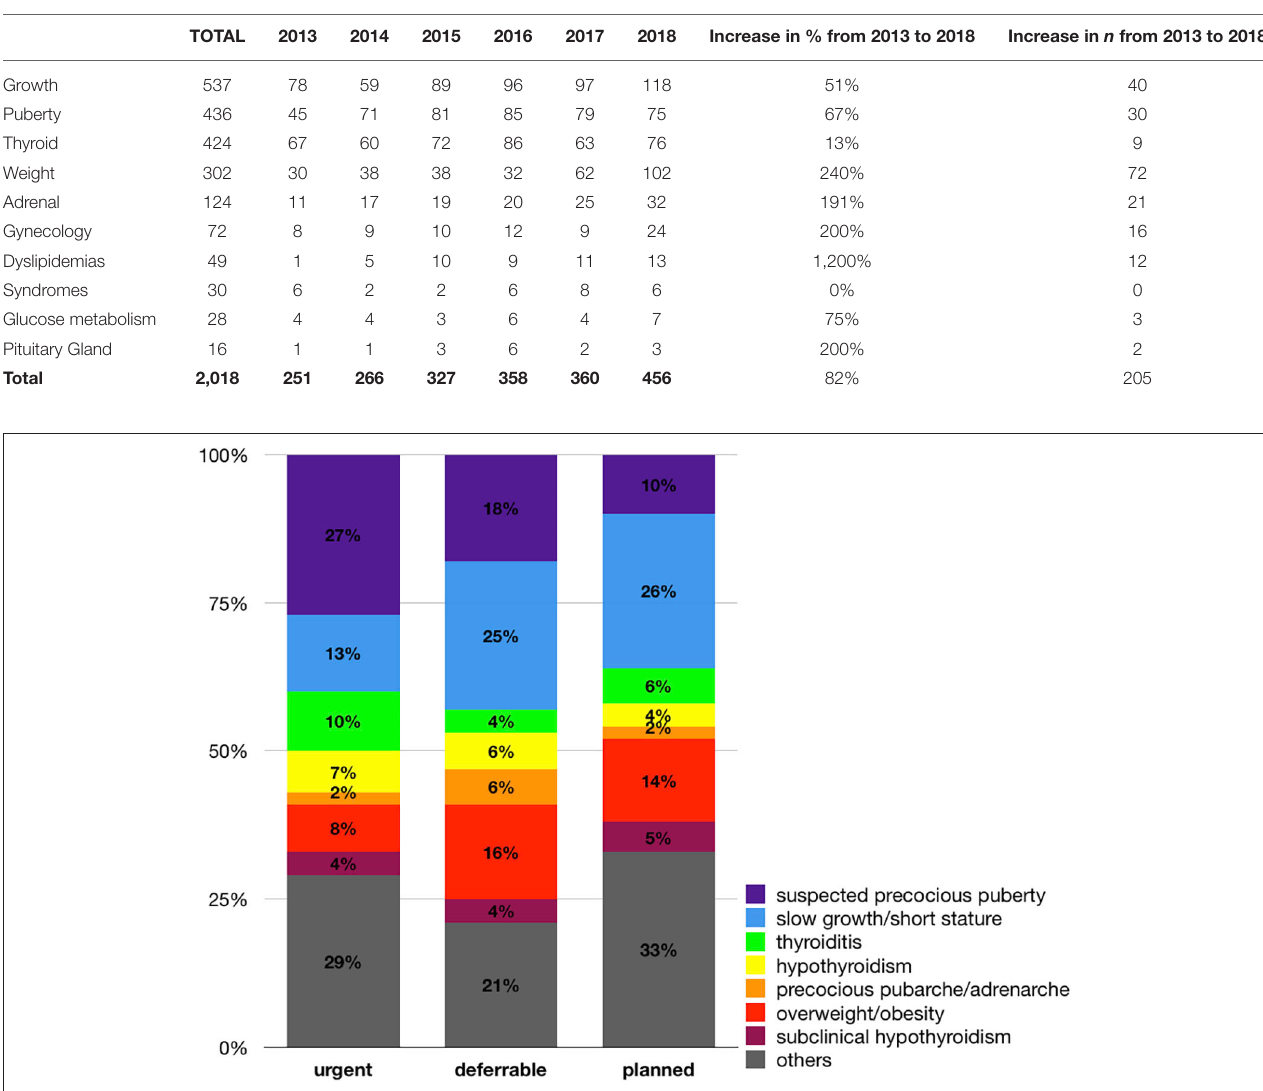
TABLE 2 | Numeric variations of referrals during the 2013–2018 period (only entire year, with data available from January to December, were included).